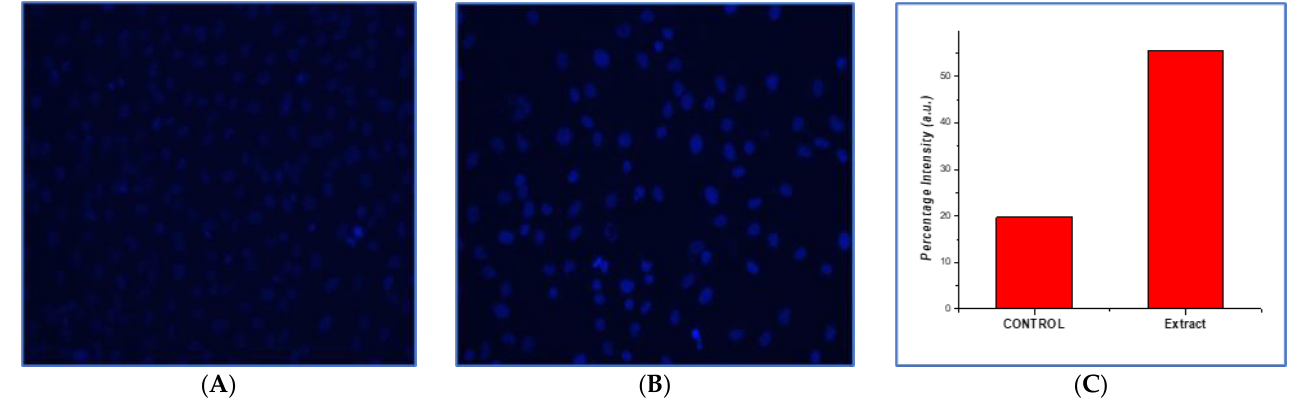
Figure 7. Images depicting the apoptotic effect of okra extract on DAPI-stained HepG2 cells at 20X magnification under a phase-contrast microscope. ( A ) Untreated HepG2 cells stained with DAPI; ( B ) okra extract-treated HepG2 cells; ( C ) fluorescence intensity graph.